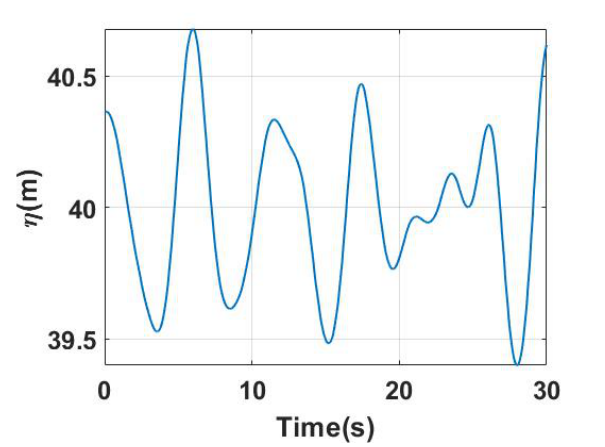
Figure 10. Free surface elevation measured at the wave probe.